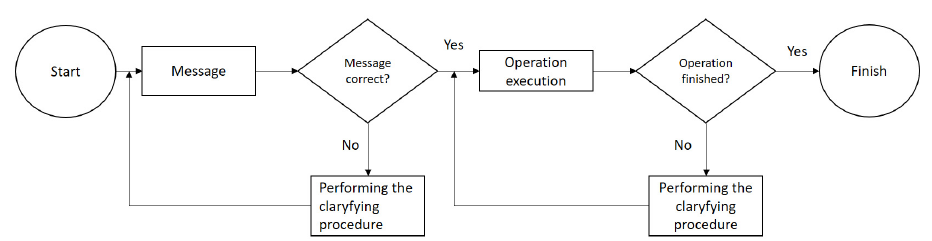
Figure 4. Operational model in any engineering system.